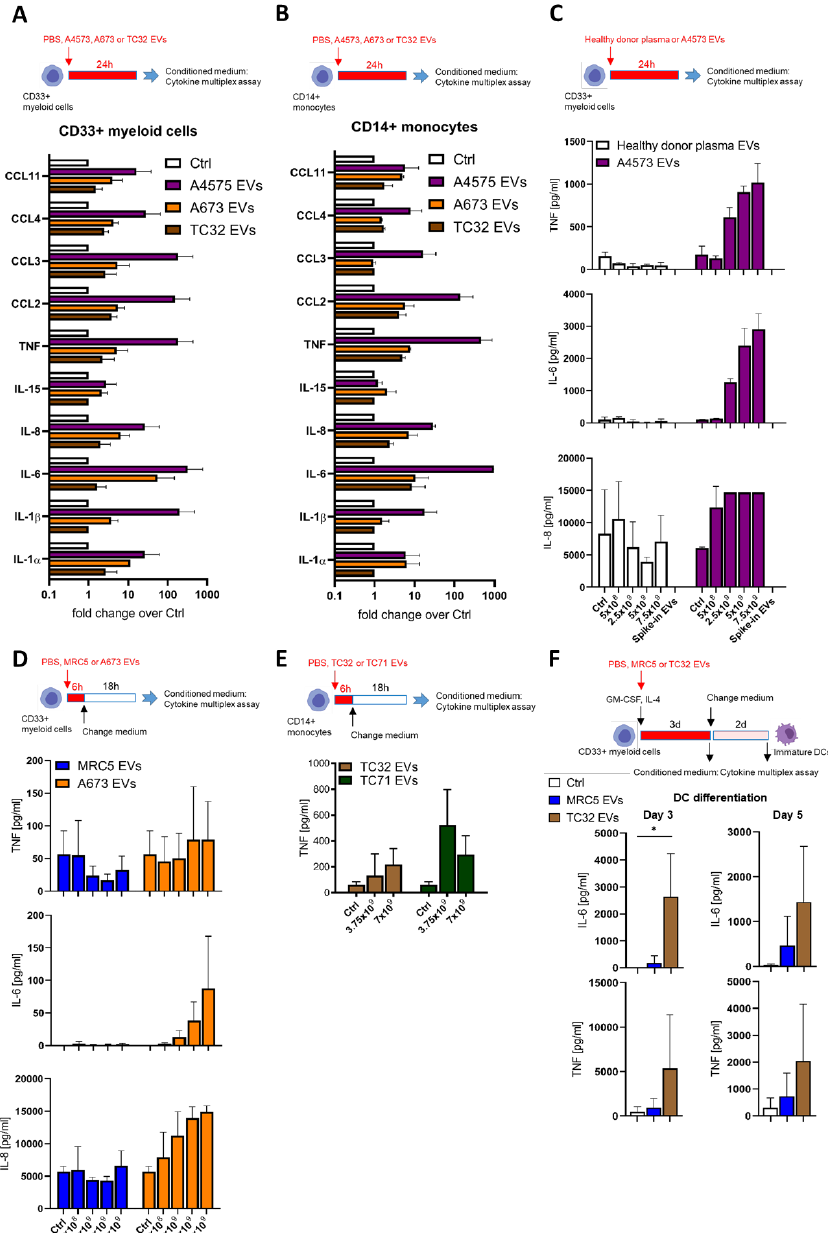
Figure 2. EwS EVs induce pro-inflammatory responses in myeloid cells. ( A – F ) Cytokine and chemokine multiplex profiling of the conditioned medium from myeloid cells treated with PBS control (Ctrl) or EVs from plasma of healthy donors, MRC5 fibroblasts, or EwS cell lines, as indicated. ( A ) CD33 + myeloid cells and ( B ) CD14 + monocytes were treated with 3 × 10 9 EVs/mL from A4573, A673, and TC32 EwS cell lines or PBS for 24 h. ( C ) CD33 + myeloid cells were incubated for 24 h with 5 × 10 8 to 7.5 × 10 9 EVs/mL from an A4573 cell line or healthy donor plasma. ( D ) CD33 + myeloid cells were incubated with 5 × 10 8 to 7.5 × 10 9 EVs/mL from A673 EwS cells or MRC5 fibroblasts. The medium was changed after 6-h treatment and analyzed 18 h later. ( E ) CD14 + myeloid cells